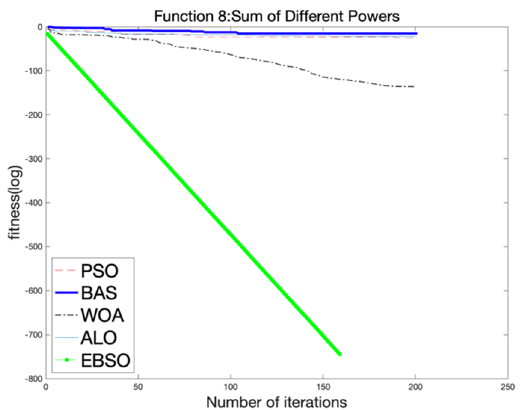
Figure 13. Figure 13. f 7 iterative convergence graph. Figure 13.